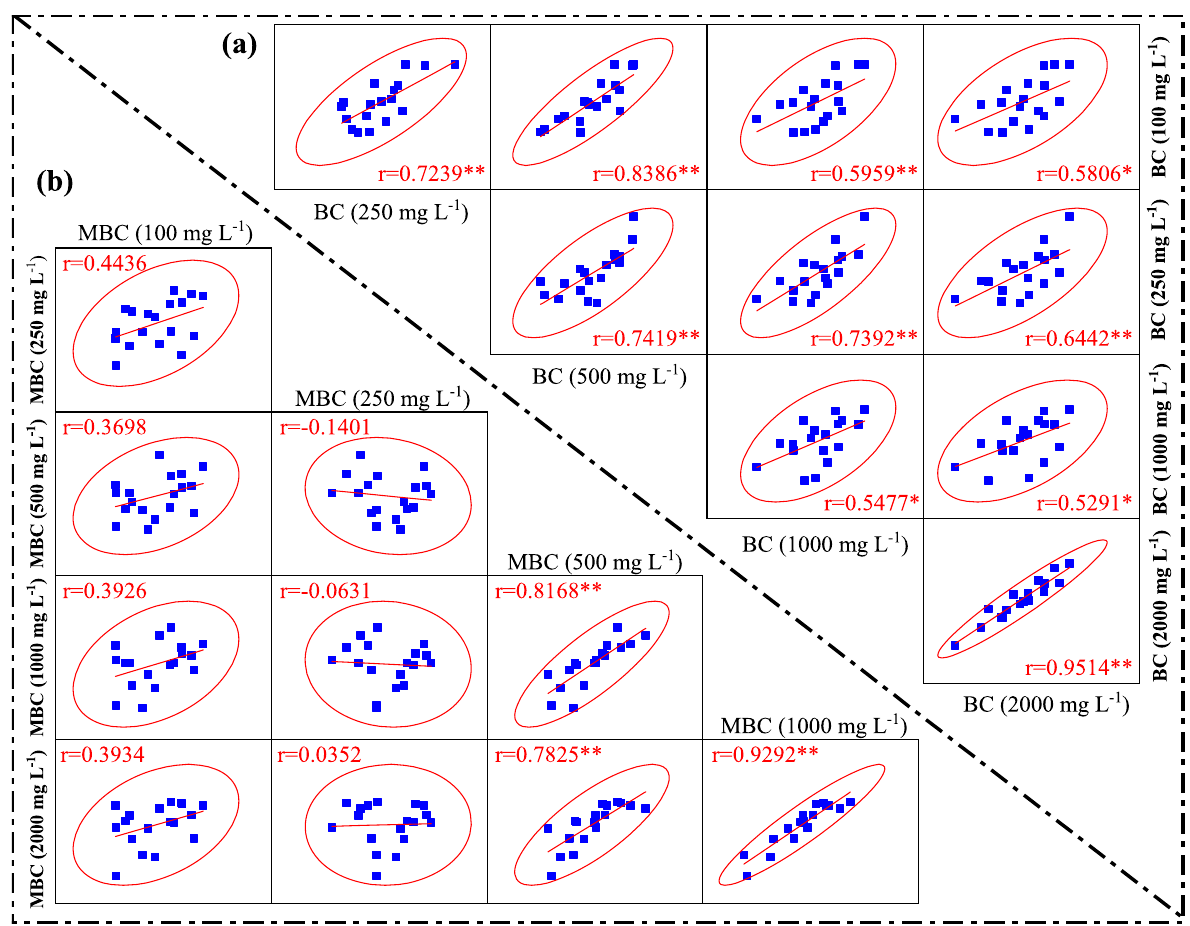
Fig. 1 Correlation analysis between the biodegradation efficiency of SMX and CAP by P. stutzeri and S. putrefaciens cultured with different concentrations of BC/MBC under the alteration between visible light irradiation and avoiding-light conditions ((note: concentration range of BC/ MBC is from 100, 250, 500, 1000 to 2000 mg L − 1 ; visible light and an avoiding light time is 12 h ×